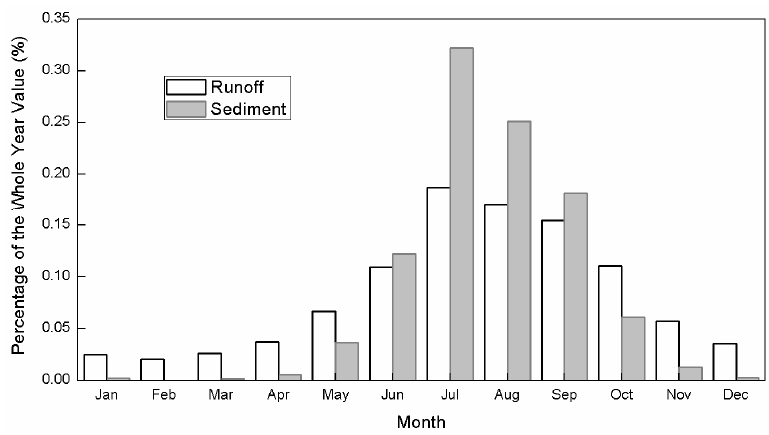
Figure 3. Monthly percentages of runoff and sediment load.